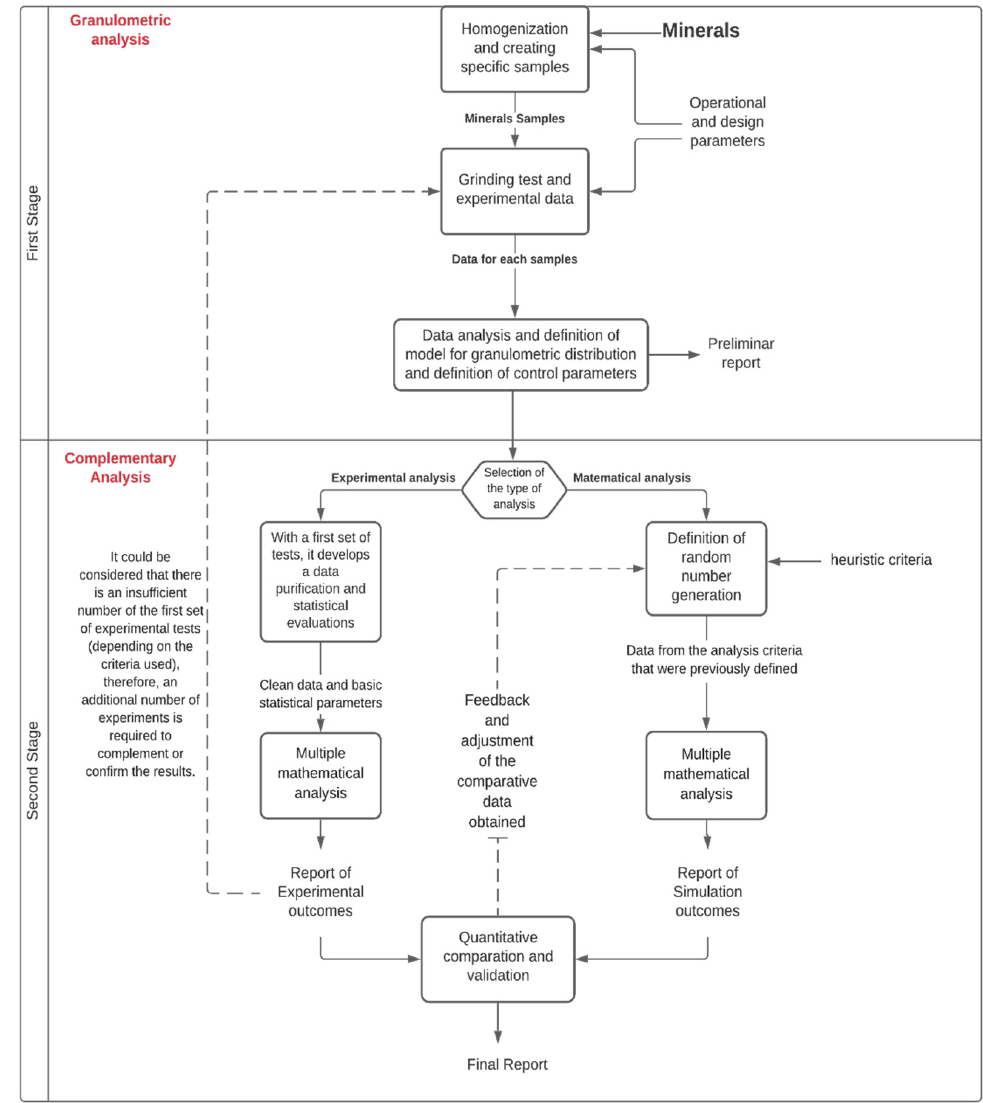
Figure 2. Illustration of the methodological proposal.